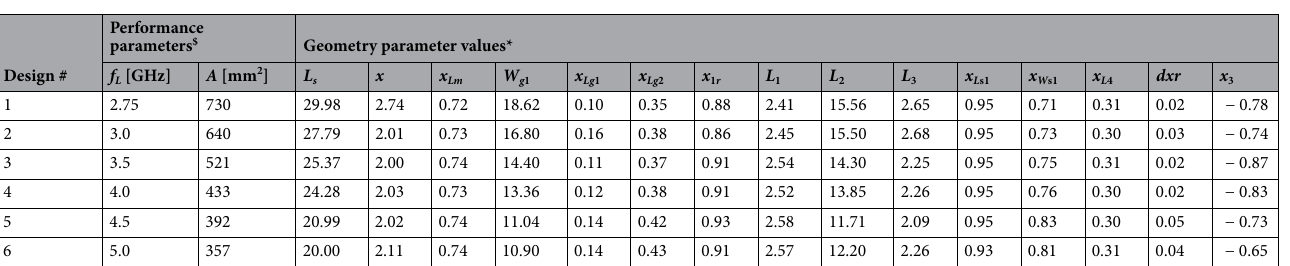
Table 3. Trade-off designs for the CP antenna of Fig. 12: geometry parameter values. $ f L and A stand for the lower end of the operating bandwidth, and the footprint area, respectively. *Absolute parameters in mm; relative parameters (ending with subscript r )